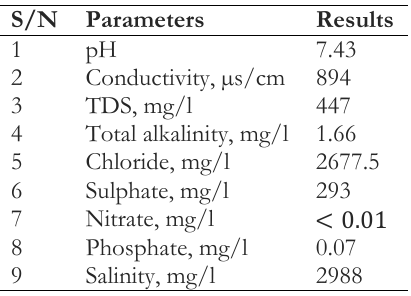
Table 2. Chemical composition of sea water